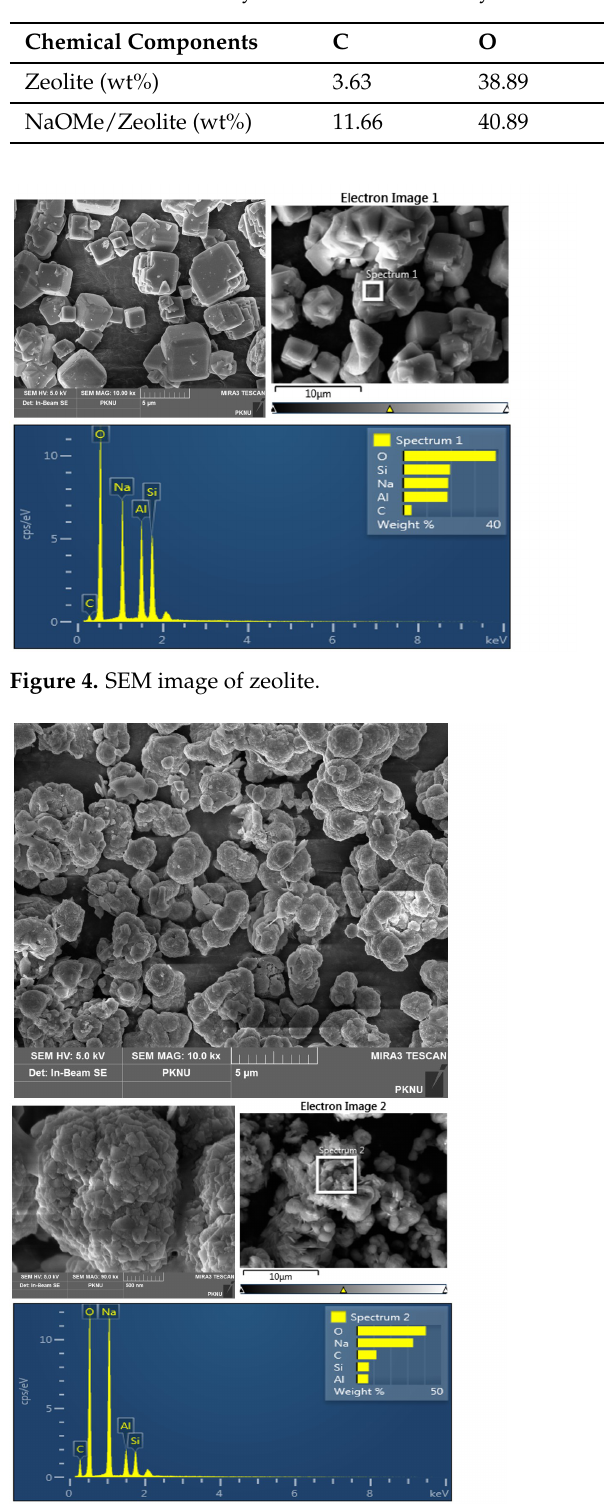
Figure 5. SEM images of NaOMe/zeolite catalyst synthesized via ball-milling